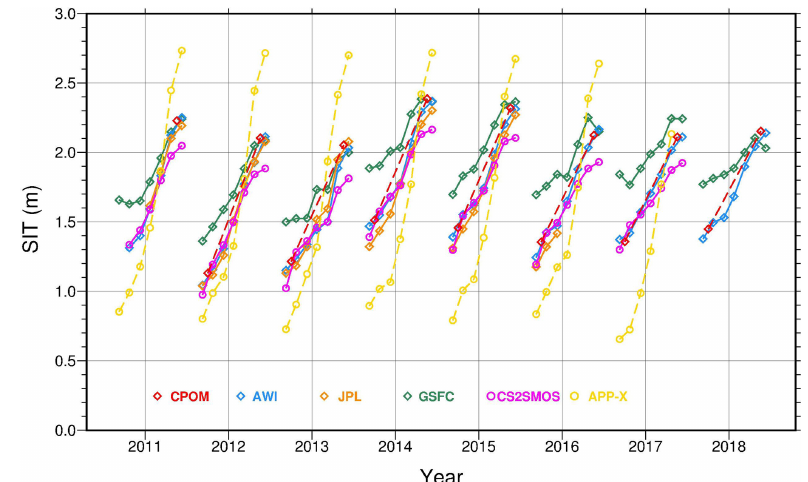
Figure 5. Sea ice thickness growth curves for October–April (monthly averages) for the central Arctic (regions 1–6) for the period 2010– 2018, subject to data availability (Table 1), indicating interannual variability in the wintertime thickness evolution. For the CPOM data product, October–November and March–April seasonal averages are shown (red diamonds connected by a dashed red